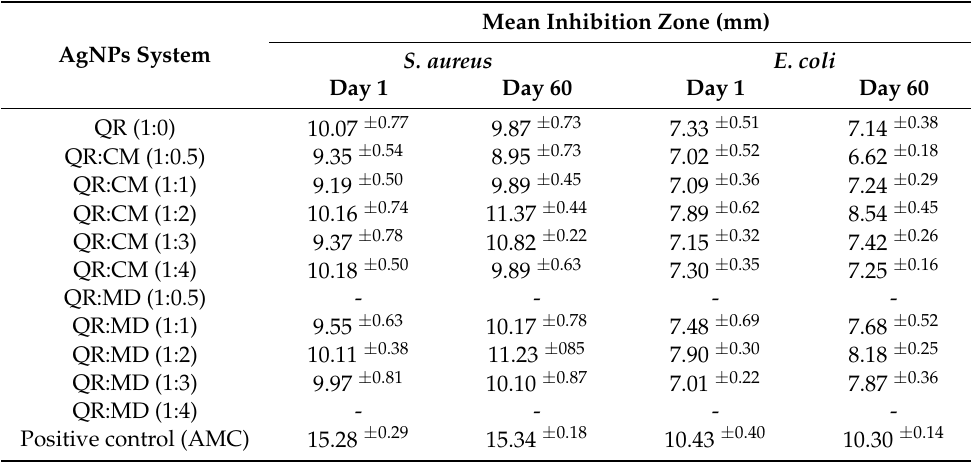
Table 2. Antibacterial activity by disc diffusion method of all AgNPs systems.